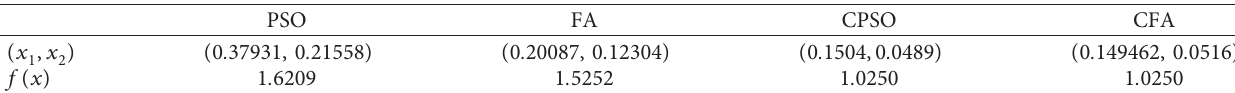
Table 2: The results of problem (1) by using